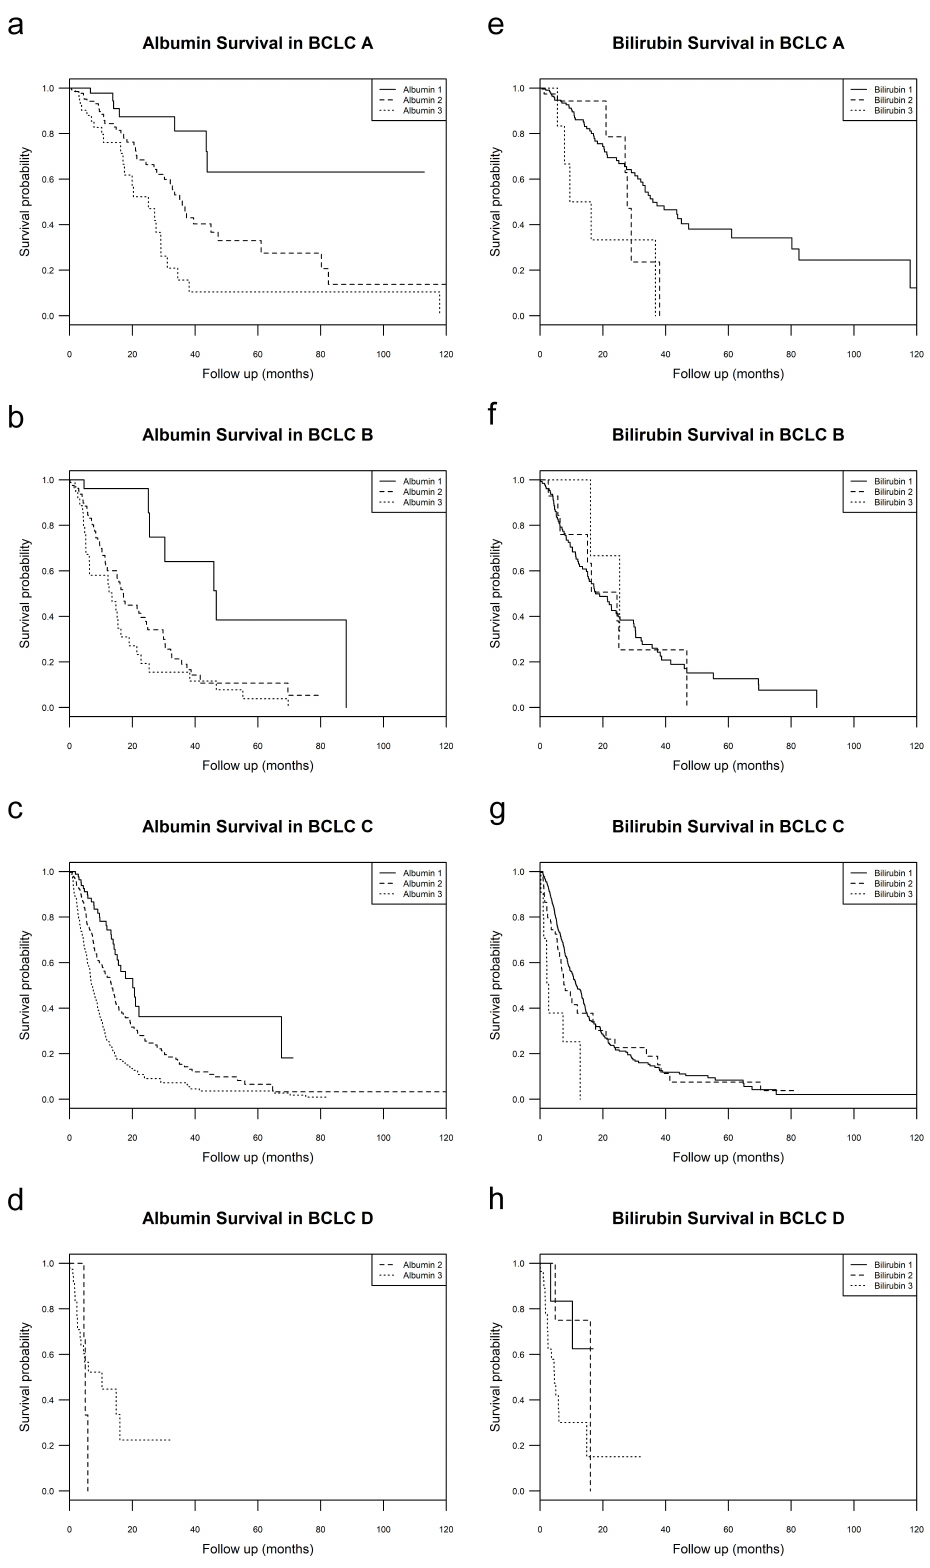
Figure 2. Albumin and bilirubin survival within BCLC stages. ( a – d , top left – bottom left ) Kaplan Meier survival curves of patients in each BCLC stage stratified by albumin grade; ( e – h , top right – bottom right ) Kaplan Meier survival curves of patients in each BCLC stage stratified by bilirubin